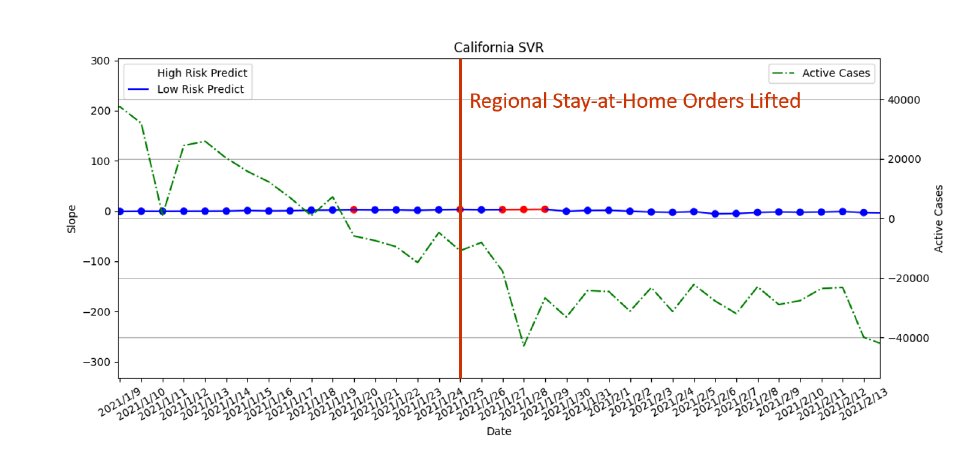
Figure 21. The result of risk analysis with PR for lifted regional stay-at-home orders in California.